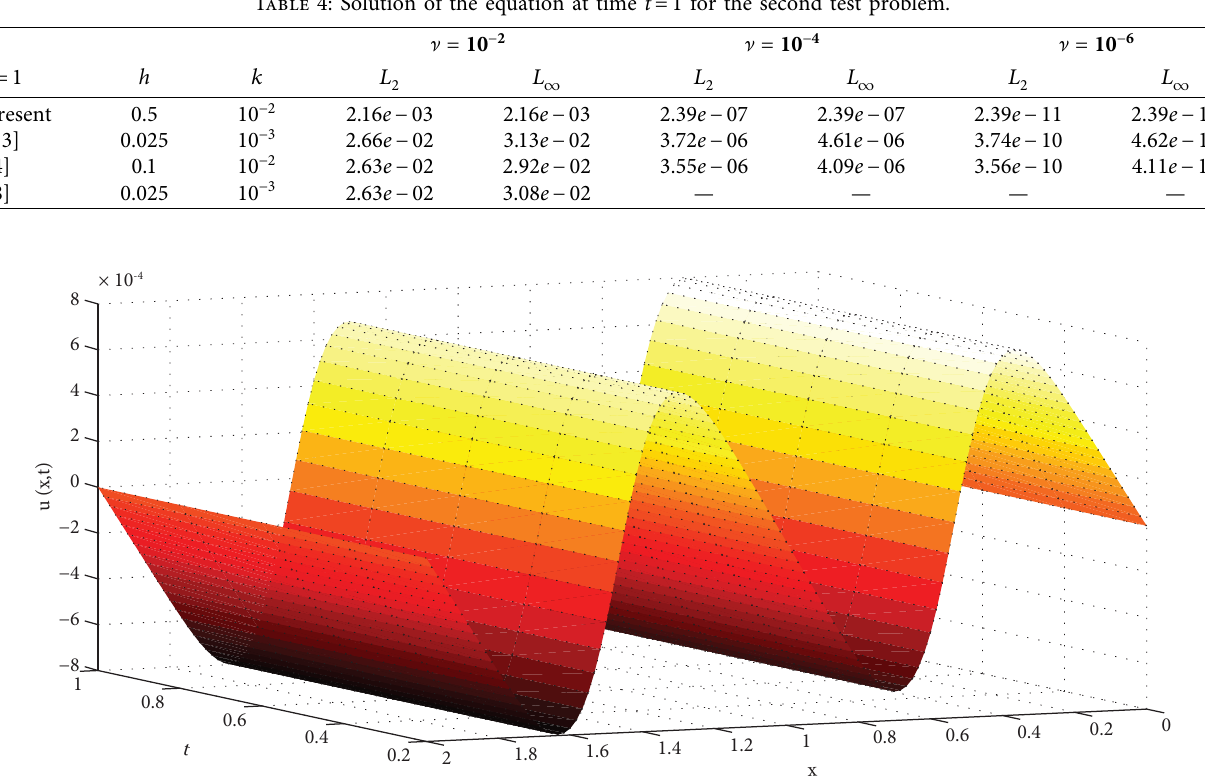
Figure 2: Physical behaviour of the numerical solutions of the second test problem for ] � 10 − 4 at diferent time